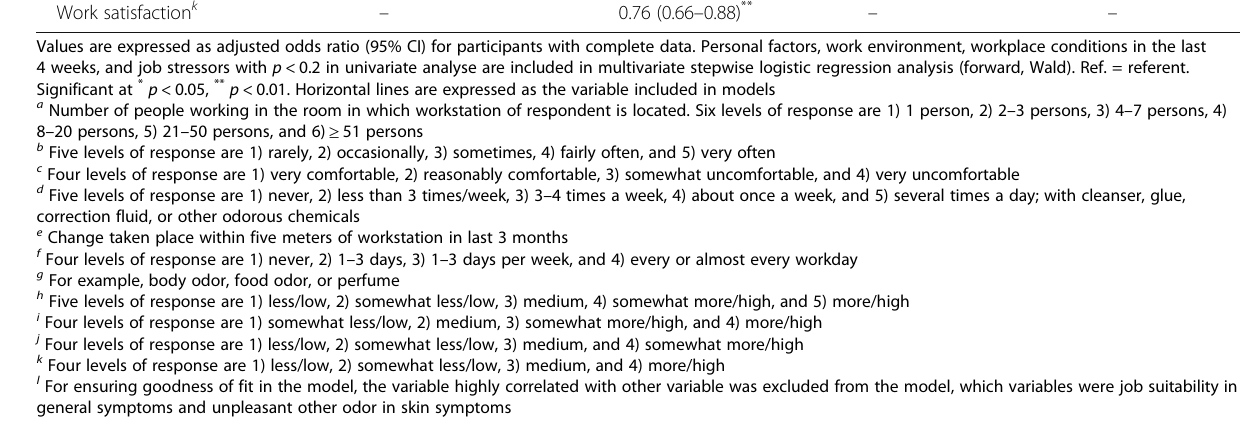
Table 6 Final models for the association between weekly building-related symptoms and all variables (Model 4) (Continued) Work satisfaction k – 0.76 (0.66 – 0.88) ** – –